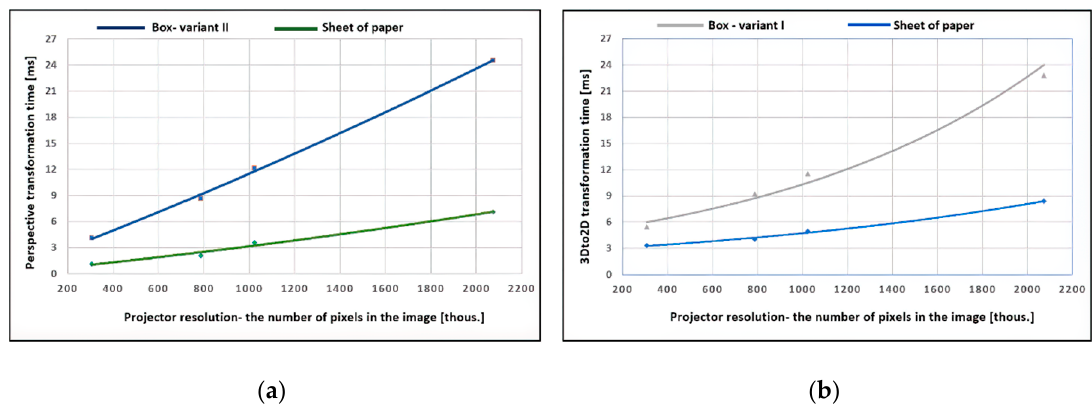
Figure 11. Graphs showing dependence of ( a ) perspective transformation time and ( b ) 3D-to-2D transformation time depending on projector resolution.